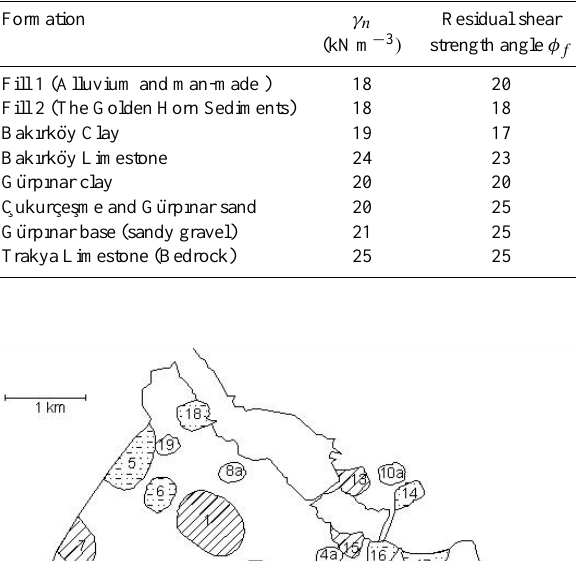
Figure 11. Comparison of the Regional Damage Map of the 1894 Earthquake (Lav, 1994) and Figure 13. Comparison of Regional Damage Map of the 1894 Earthquake (Lav, the ground shaking microzonation map prepared for probability of exceedance of 10% in 50 1994) and Liquefaction Susceptibility microzonation map prepared for the years. ( İ nce, 2005). probability of exceedance of 10% in 50 years ( İ nce, 2005).